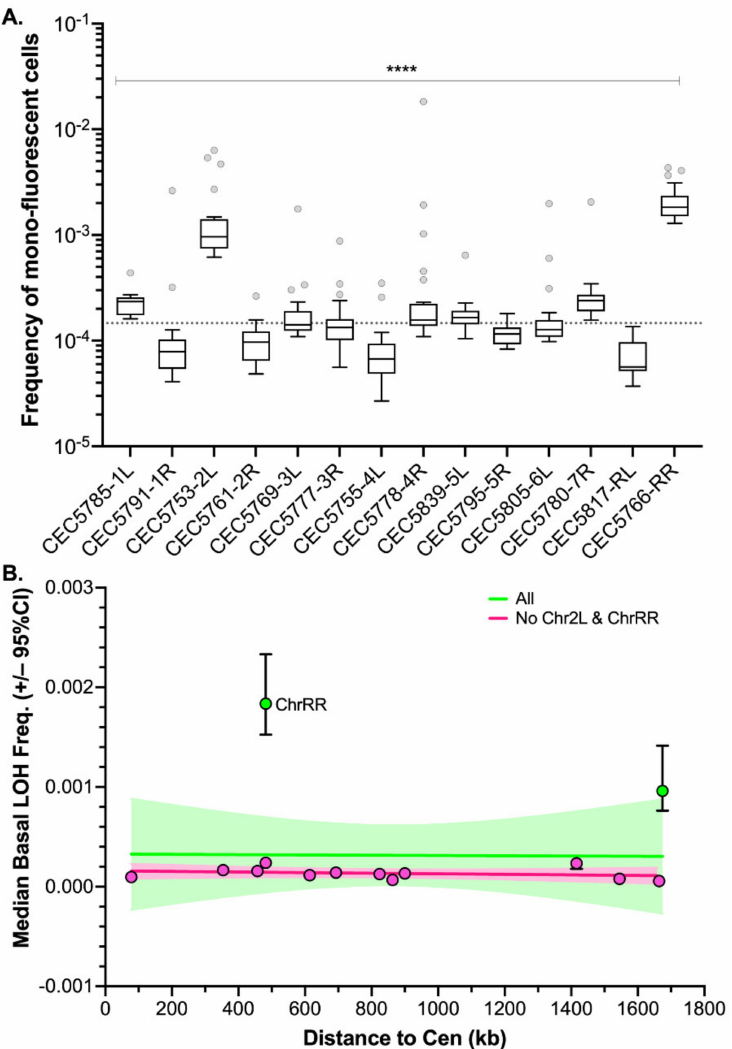
Figure 3. Median basal LOH frequencies across 14 C. albicans genomic loci. ( A ) Box plot and whiskers (Tukey) of median basal LOH frequencies obtained upon fluctuation analysis using the Blue-Green collection ( n = 24 parallel cultures). The median basal LOH frequency of the 14 genomic loci is represented by the gray dashed line. Significant differences between medians were assessed using the Kruskal–Wallis test (**** p < 0.0001). ( B ) Relationship between median basal LOH frequency (error: 95% CI) and the distance between the BFP/GFP LOH reporter system and the centromere (CEN) (kb). Linear regression of all 14 loci represented in green (Pearson’s R = − 0.0149, p = 0.962114) and of 13 loci (without ChrRR possession rDNA locus) represented in pink (Pearson’s R = 0.3826, p =